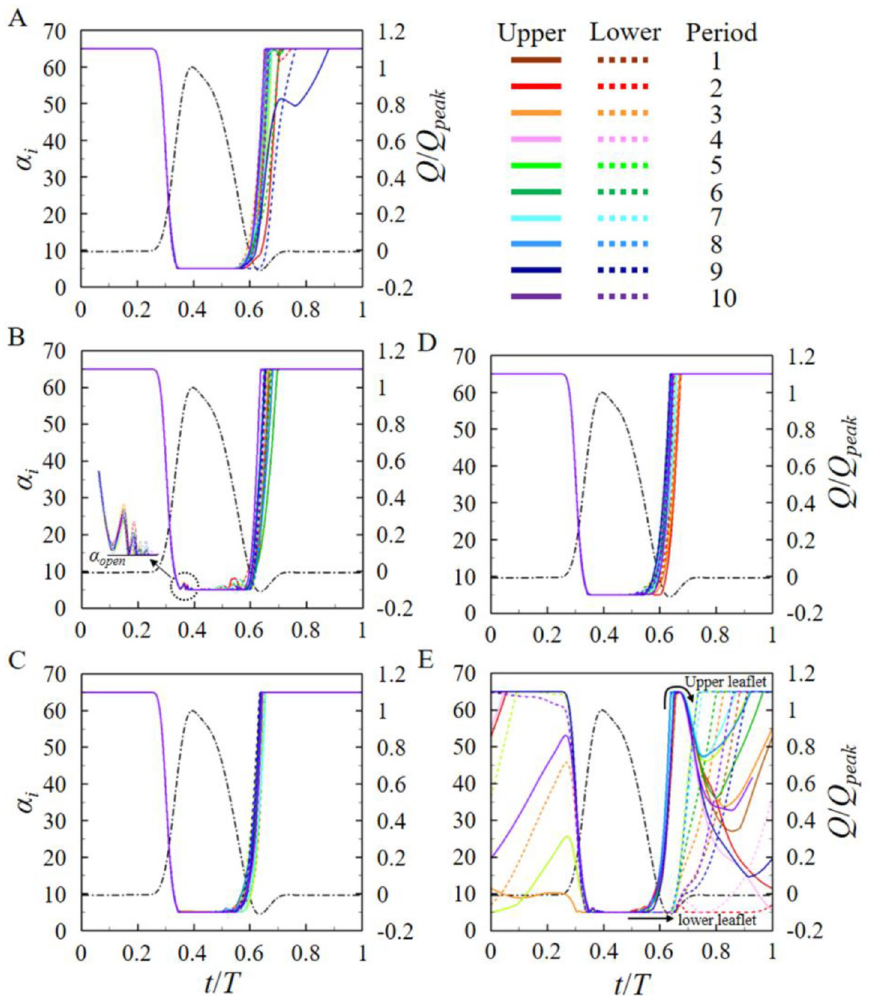
Fig 4. Time histories of the angles of the upper and lower leaflets during ten cycles. (A) No pannus. (B) Circular pannus. (C) Left semi-circular pannus. (D) Right semi-circular pannus. (E) Upper semi-circular pannus. Here, the black chain-dotted line in each figure is the inflow rate normalized by the peak inflow rate, and the colored solid and dashed lines denote the motions of upper and lower leaflets during ten cycles, respectively. The height of pannus is h = 0.12 D